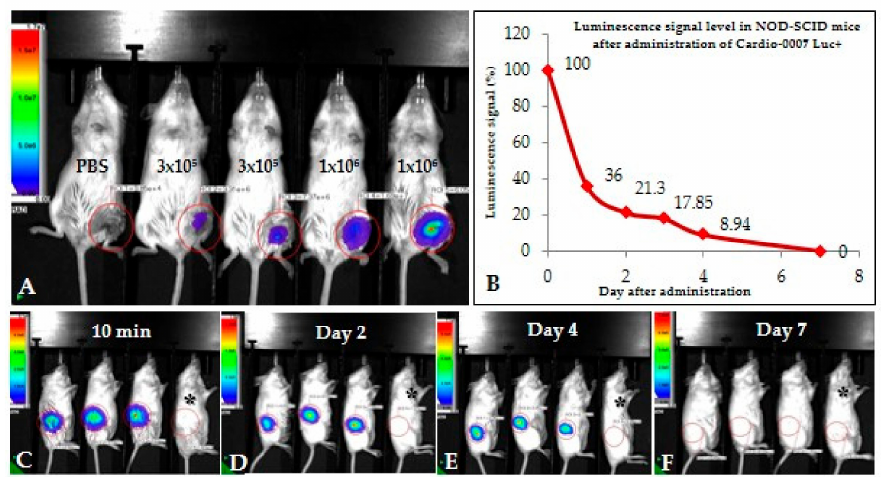
Figure 2. ( A ) The intensity of the luminescence signal after the administration of di ff erent doses of Cardio-0007 Luc + (3 × 10 5 and 1 × 10 6 cells). A dose of 1 × 10 6 cells has been selected for further experiments. ( B – F ) Intensity of the luminescence signal after administration of 1 × 10 6 cells. The signal is undetectable after 7 days; black asterisk–control mouse without injected cells.